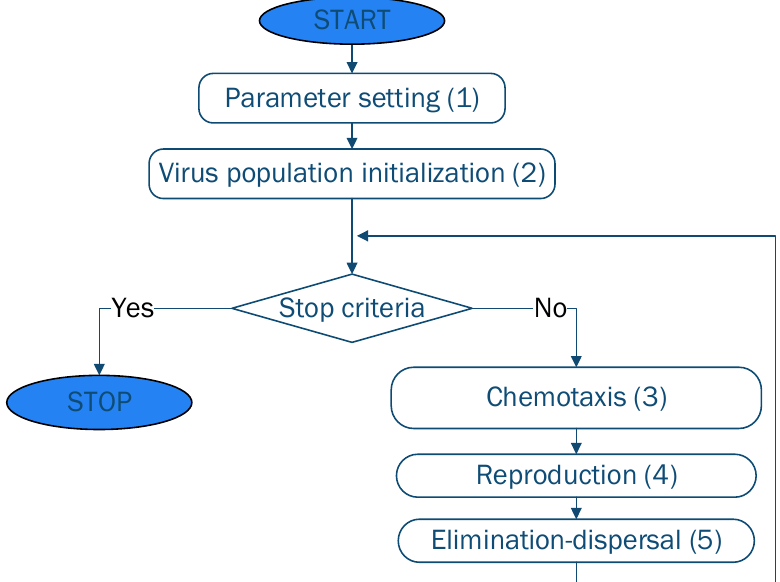
Figure 1. Simplified schema of the BFO algorithm.